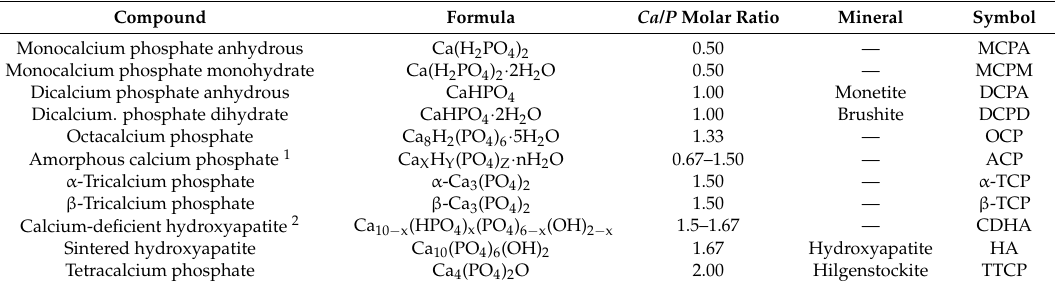
Table 1. Main calcium orthophosphate compounds